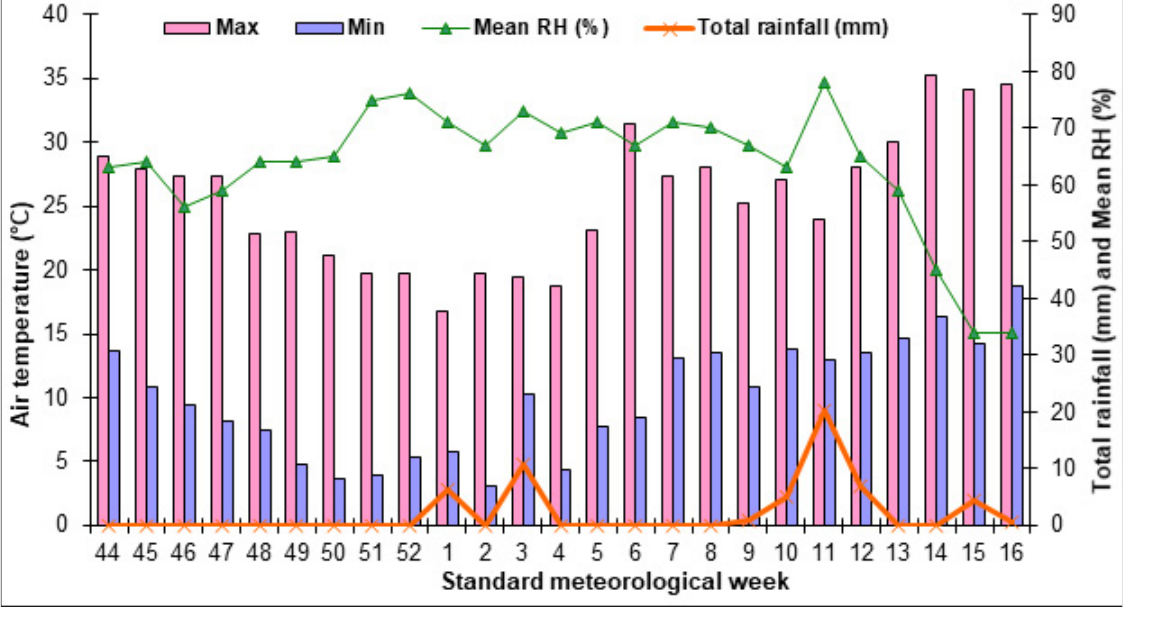
Figure 2: Weekly meteorological data recorded at meteorological observatory at Punjab Agricultural University, Ludhiana during the crop season